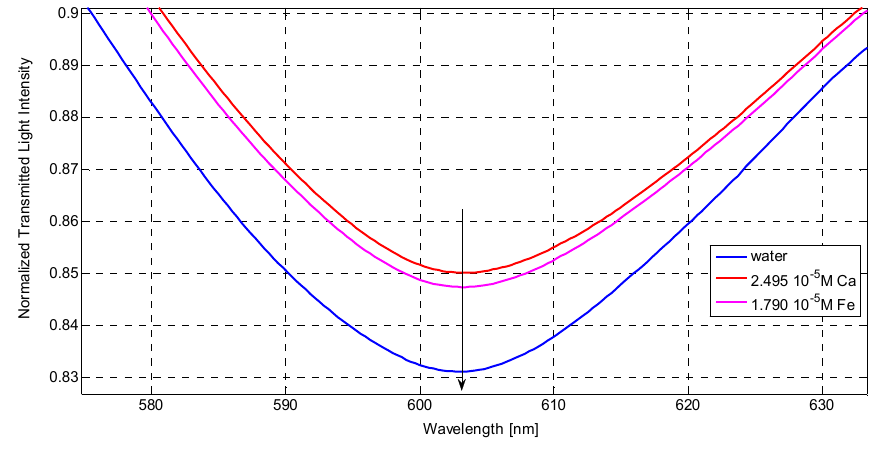
Figure 2. SPR transmission spectra, normalized to the air spectrum, for different analytes: Ca and Fe. For comparison, the spectrum of pure water is